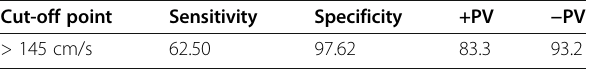
Table 5 The cut-off point, sensitivity and specificity of HAV thresholds to MELD Cut-off